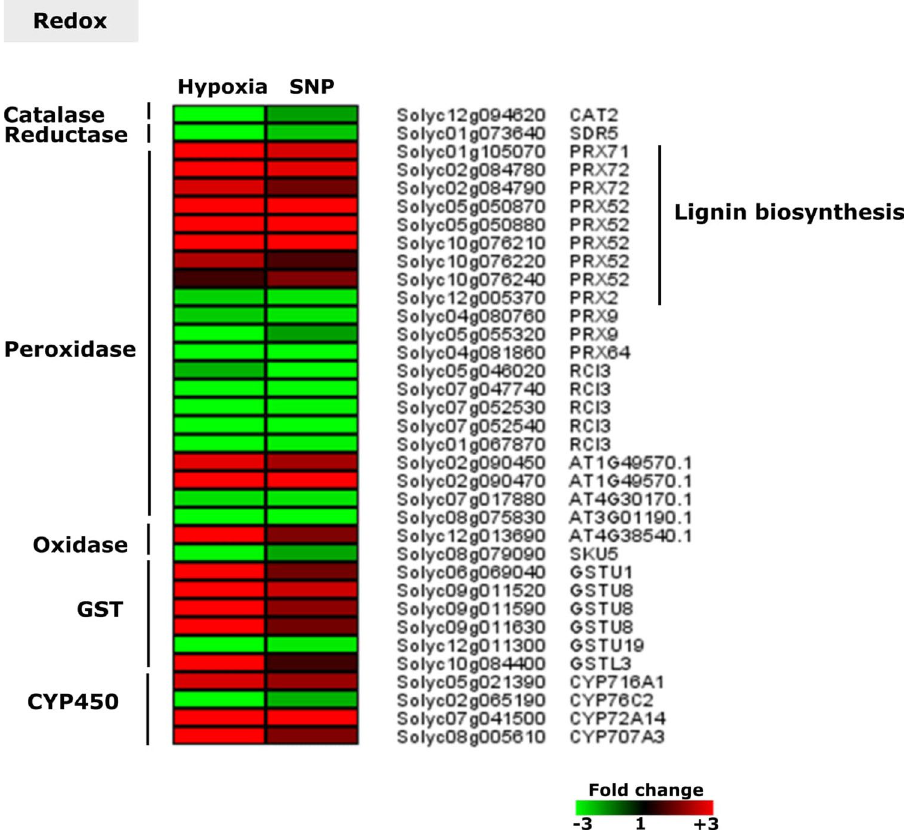
Figure 8. Expression pattern of genes encoding members of different antioxidant classes. Heat map represents the up-regulated (red bars) or down-regulated (green bars) tomato genes and their Arabidopsis thaliana homologs in response to hypoxia and SNP-treatment. Depicted are differentially expressed genes ( Padj < 0.05), ( n = 3). GST , GLUTATHIONE S-TRANSFERASE ; CAT2 , CATALASE 2 ; SDR5 , SHORT- CHAIN DEHYDROGENASE REDUCTASE 5 ; PRX71 , PEROXIDASE 71 ; PRX72 , PEROXIDASE 72 ; PRX52 , PEROXIDASE 52 ; PRX2 , PEROXIDASE 2 ; PRX9 , PEROXIDASE 9 ; PRX64, PEROXIDASE 64 ; RCI3 , RARE COLD INDUCIBLE GENE 3 ; SKU5 ; encodes SKU5 protein ; GSTU1 (GST19) , GLUTATHIONE S-TRANSFERASE TAU 1 (GLUTATHIONE S-TRANSFERASE 19) ; GSTU8 , GLUTATHIONE S-TRANSFERASE TAU 8 ; GSTU19 (GST8) , GLUTATHIONE S-TRANSFERASE TAU 19 (GLUTATHIONE S-TRANSFERASE 8) ; GSTL3 , encoding a member of glutathione S-transferase family protein ; CYP716A1 , CYTOCHROME P450 , FAMILY 716 , SUBFAMILY A , POLYPEPTIDE 1 ; CYP76C2 , CYTOCHROME P450 , FAMILY 76 , SUBFAMILY C , POLYPEPTIDE 2 ; CYP72A14 , CYTOCHROME P450 , FAMILY 72 , SUBFAMILY A , POLYPEPTIDE 14